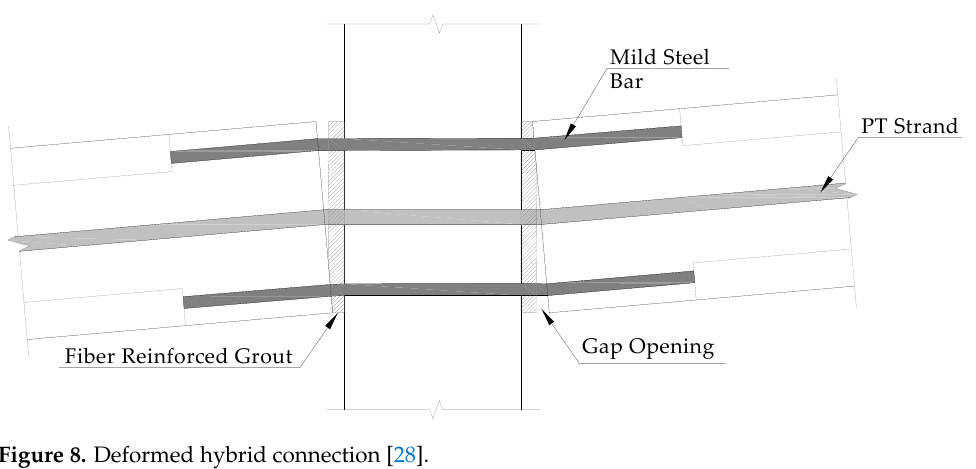
Figure 8. Deformed hybrid connection [28].